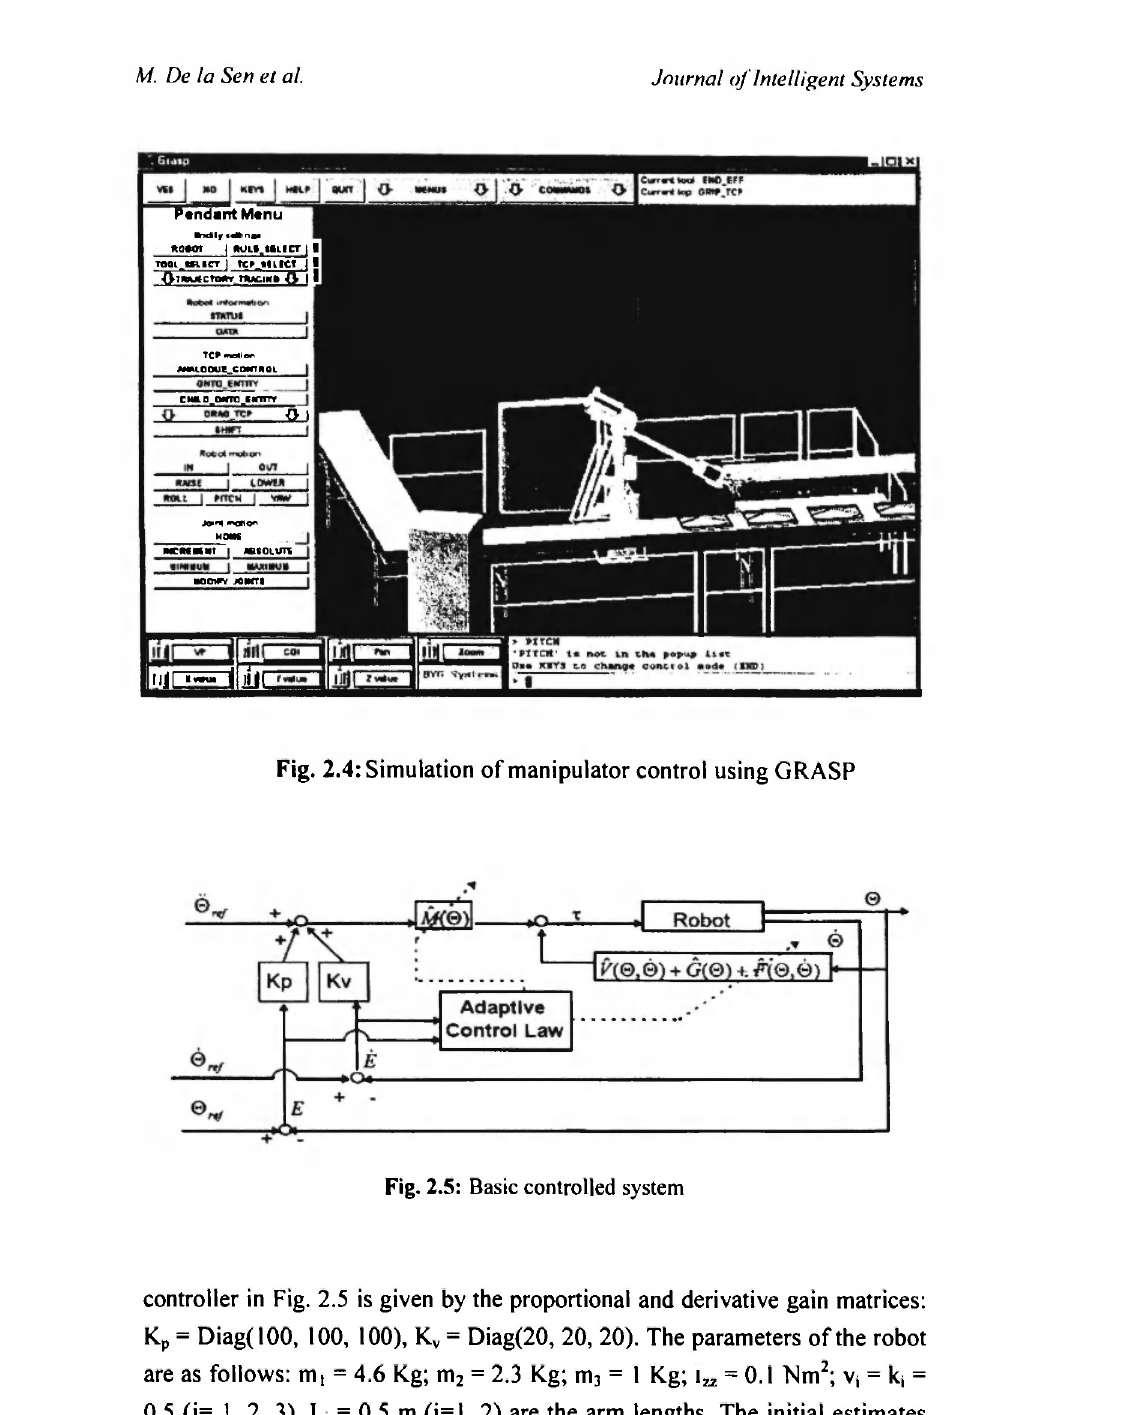
Fig. 2.5: Basic controlled